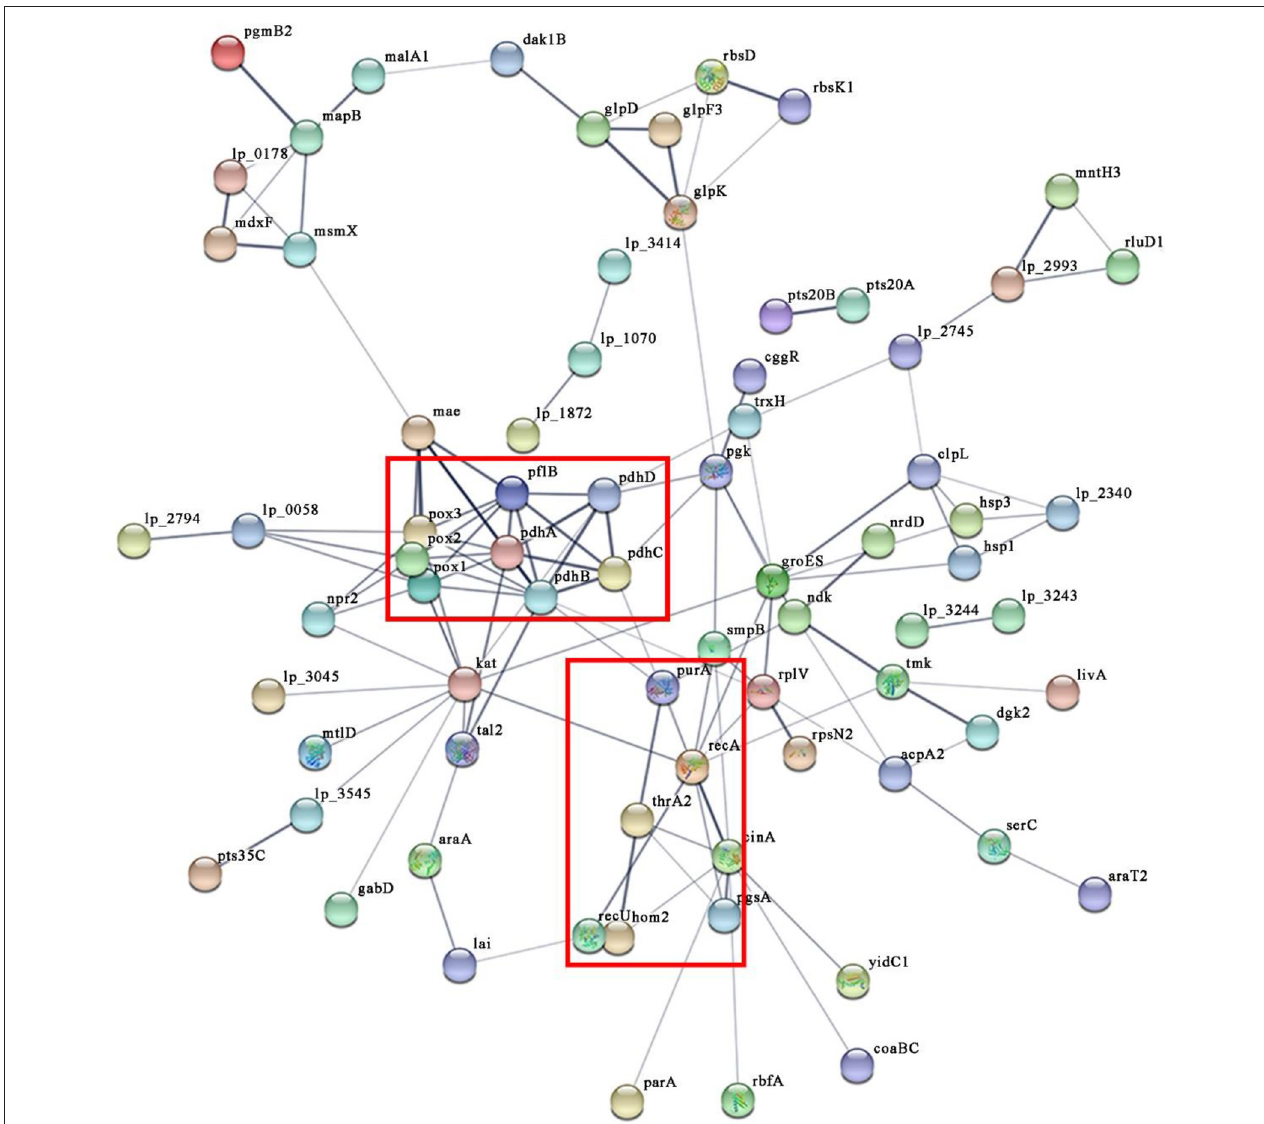
FIGURE 6 | The protein-protein interaction networks of differentially expressed proteins in L. plantarum KM1 under H 2 O 2 stress. Different circles represent different proteins, and there is a line in the middle indicating that there may be an interaction relationship. pox1, pyruvate oxidase; pox2, hypothetical protein; pox3, pyruvate oxidase; pdhA, pyruvate dehydrogenase E1 component subunit alpha; pdhB, pyruvate dehydrogenase E1 component subunit beta; pdhC, dihydrolipoyllysine-residue acetyltransferase component of pyruvate dehydrogenase complex; pdhD, dihydrolipoyl dehydrogenase; pflB, formate acetyltransferase; mae, NAD-dependent malic enzyme; gabD, succinate-semialdehyde dehydrogenase [NADP( + )] 1; npr2, NADH peroxidase; kat, SsrA-binding protein; hom2, homoserine dehydrogenase; thrA2, aspartokinase 3; purA, adenylosuccinate synthetase; recA, protein RecA; recU, holliday junction resolvase RecU (abbreviation for important